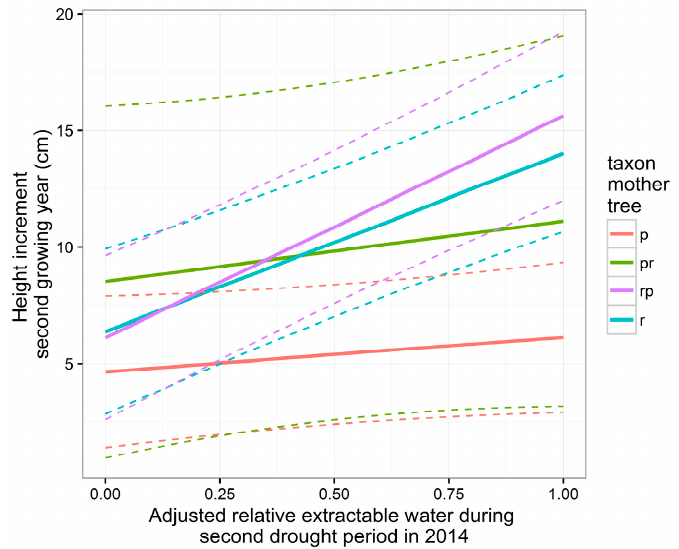
of the diameter growth in the second growing season, also in interaction with the weight loss of the pots (Figure 5 and Table 4) but independent of the height of the seedlings at the end of the growing season in 2014.